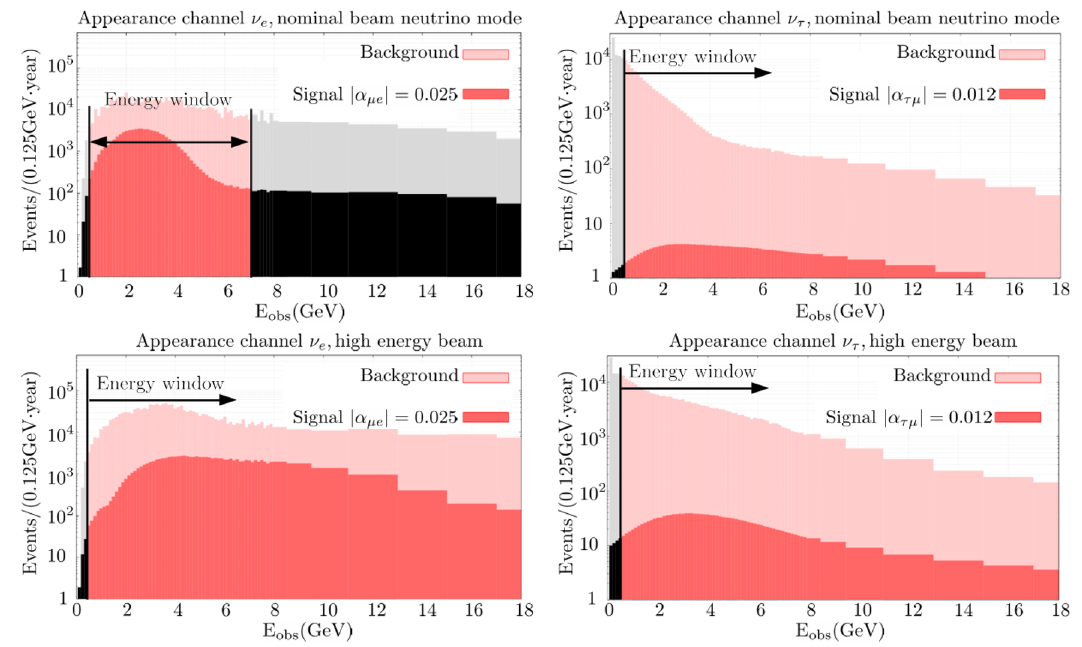
Figure 2 . Event distributions as a function of the observed energy in the detector. Upper (lower) panels show the expected rates for the nominal (HE) beam configuration, for one year of data taking in neutrino mode. The light (dark) histograms correspond to the total background (signal) events for the NU case, with α µe and α τµ as indicated by the labels. The resulting histograms for antineutrino mode are qualitatively similar to the upper panels and are not shown here. The colored bins (labeled as “Energy window”) indicate the events included in the analysis, see text for